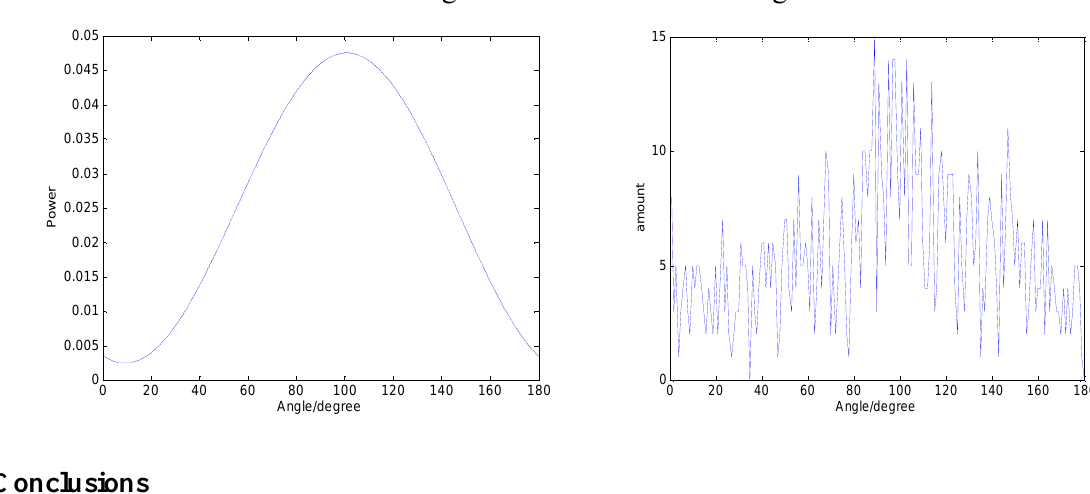
Figure 13. The results of the two methods (DOA =